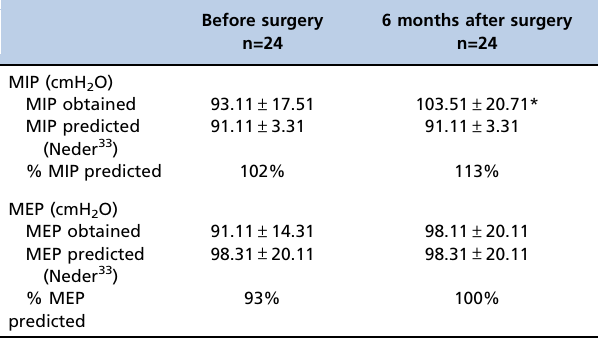
Table 3 - Static maximum respiratory pressure before and after bariatric surgery. Before surgery n=24